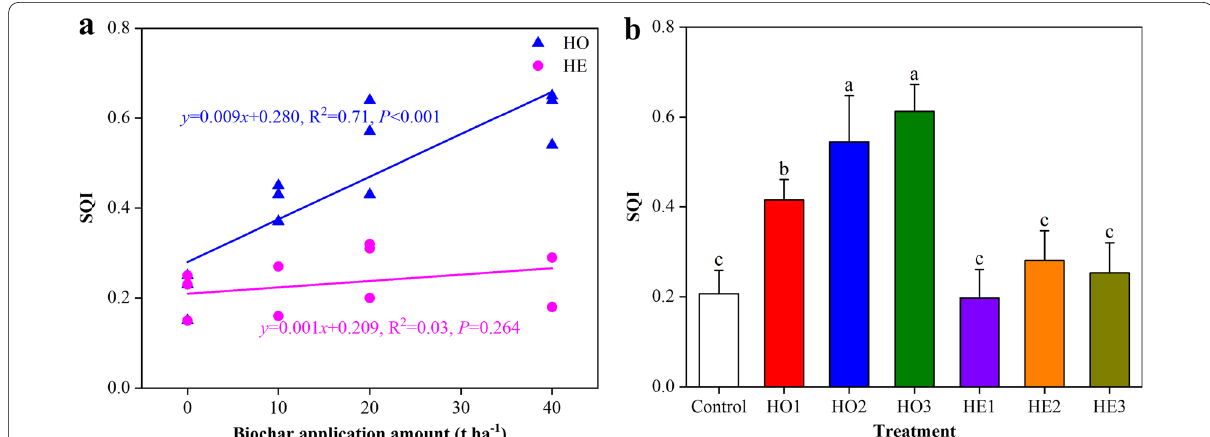
Fig. 3 Soil quality index (SQI) as affected by biochar application methods and amount. a SQI under different treatments after three continuous cropping years. b The relationship between SQI and biochar application amount. HO, homogeneous application; HE, heterogeneous application; 1, 2 and 3, biochar application was 10, 20 and 40 t ha − 1 , respectively, in both HO and HE treatments, Control, biochar application was 0. The same lowercase letter represents no significant difference ( P > 0.05) between